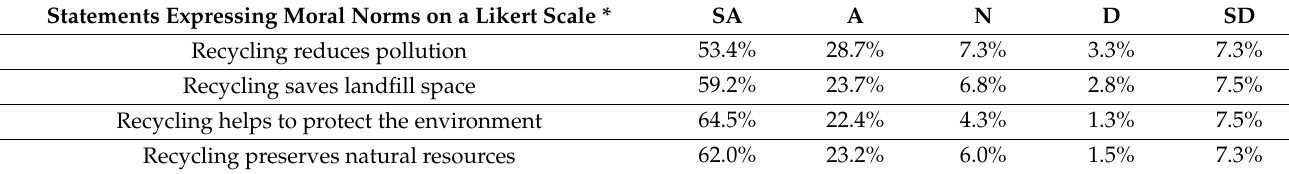
Table 9. Outcomes of